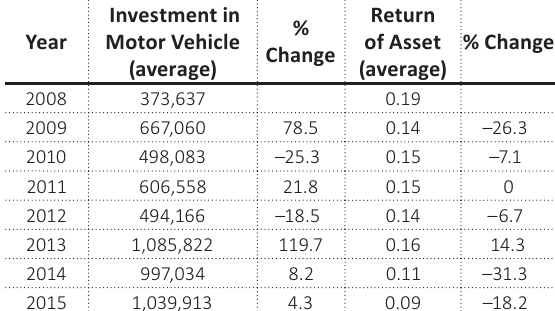
Table 3. Changes in investment in motor